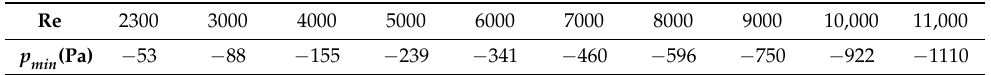
Figure 11. Pressure distribution when Re = 4000.